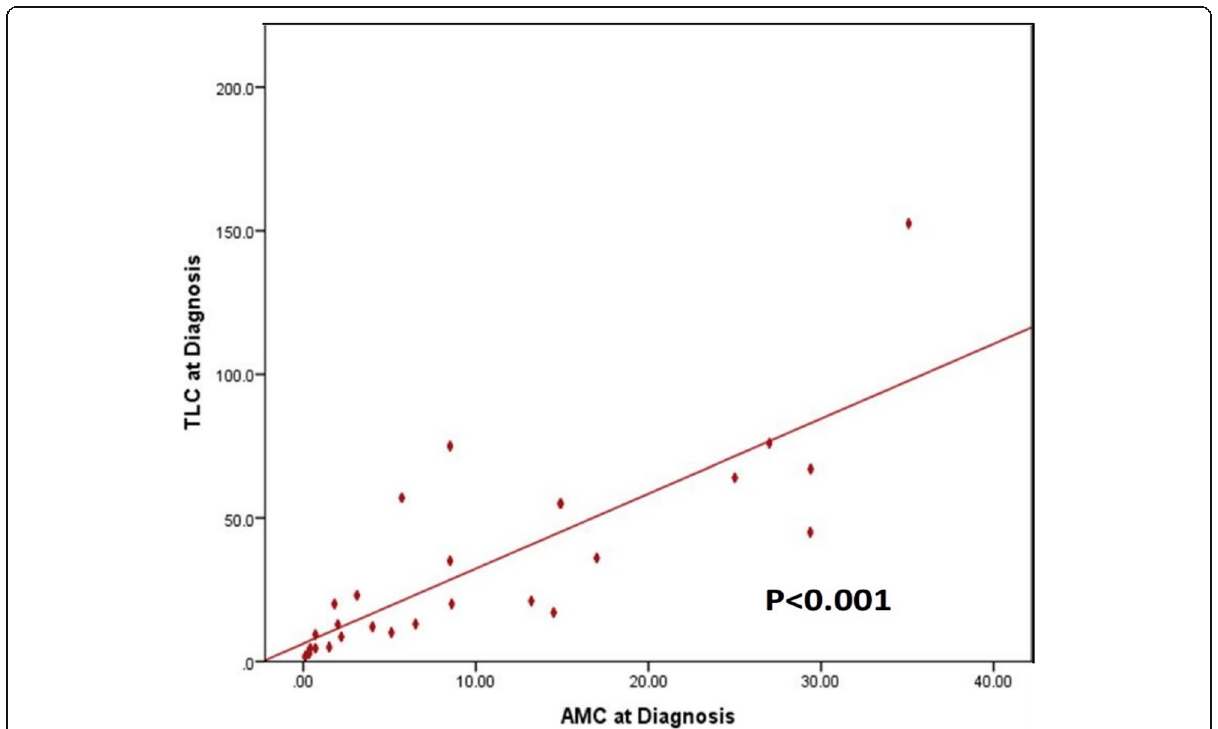
Fig. 3 Linear correlation between the initial AMC (absolute monocyte count) and TLC (total leucocyte count)